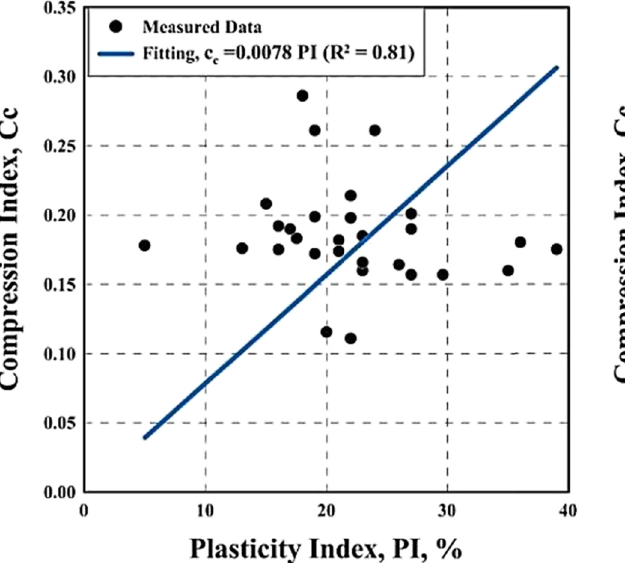
Figure 20: Compression index versus void ratio relationship. Figure 18: Compression index versus PI relationship.